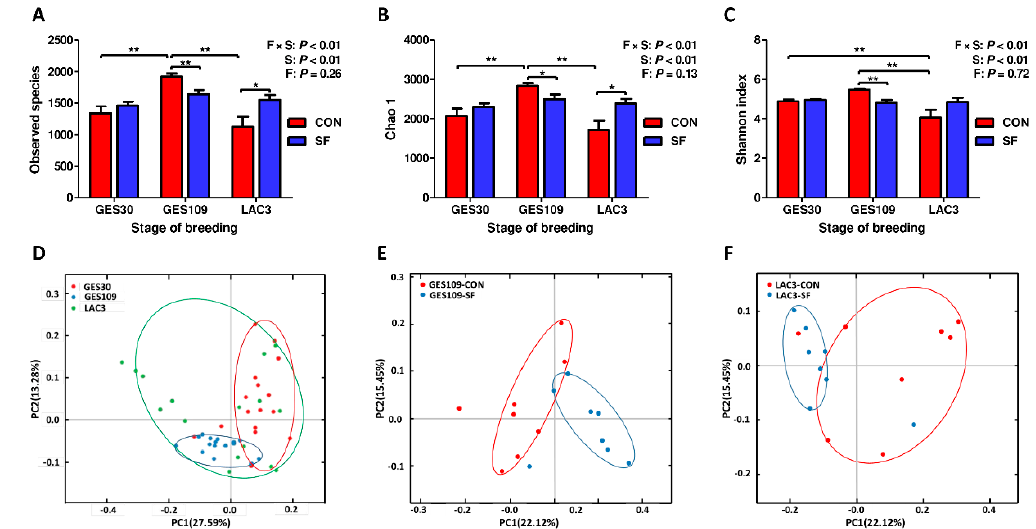
Figure 1. Effects of soluble fiber during gestation on the gut microbiota diversity of sows. ( A to C ) Comparison of the number of observed species ( A ), Chao 1 ( B ), and Shannon index ( C ) between CON- and SF-fed sows. (D–F) Beta diversity of gut microbiota in sows among different breeding stages ( D ) and between different dietary treatments at day 109 of gestation ( E ) and day 3 of lactation ( F ) based on weighted UniFrac distance. Data are expressed as mean ± SEM ( n = 8). When significant interactive effects or main effects were observed, the means were compared using the least significant difference method with a p < 0.05 indicating significance. * p < 0.05; ** p < 0.01. GES109, day 109 of gestation; LAC3, day 3 of lactation. CON, control diet; SF, 2.0 % soluble fiber combination diet.